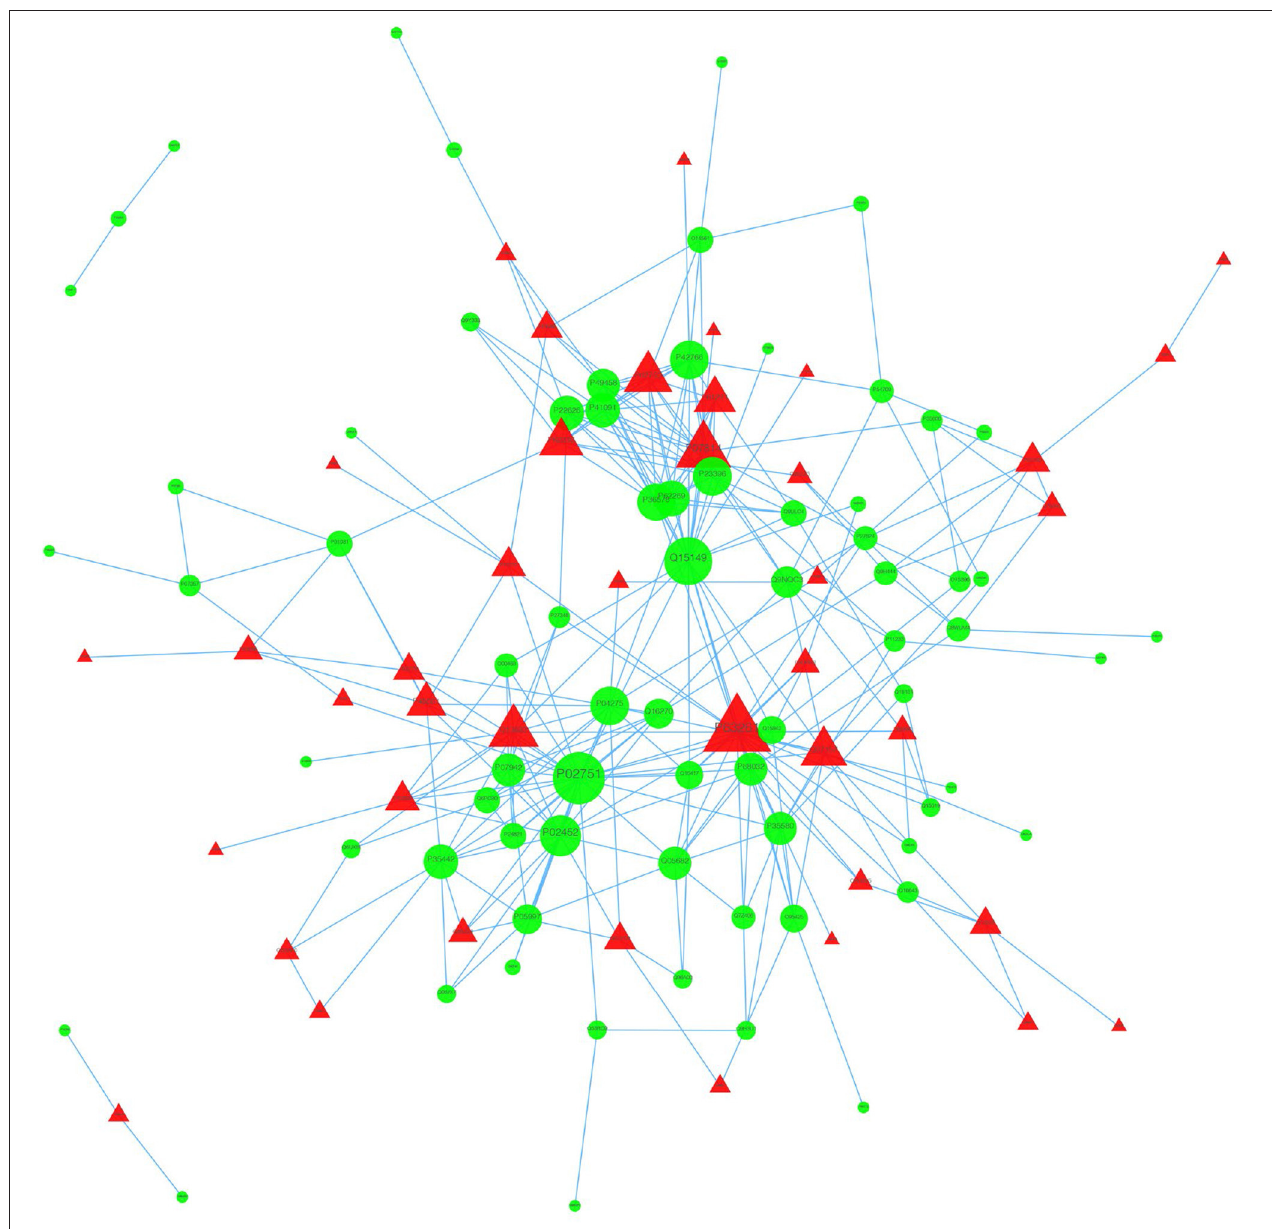
FIGURE 7 | Visualization of PPIs between the SDAVF-DV and STA. Visualization of PPIs for the top 300 proteins using STRING analysis. Red represents upregulated proteins, and green represents downregulated proteins.